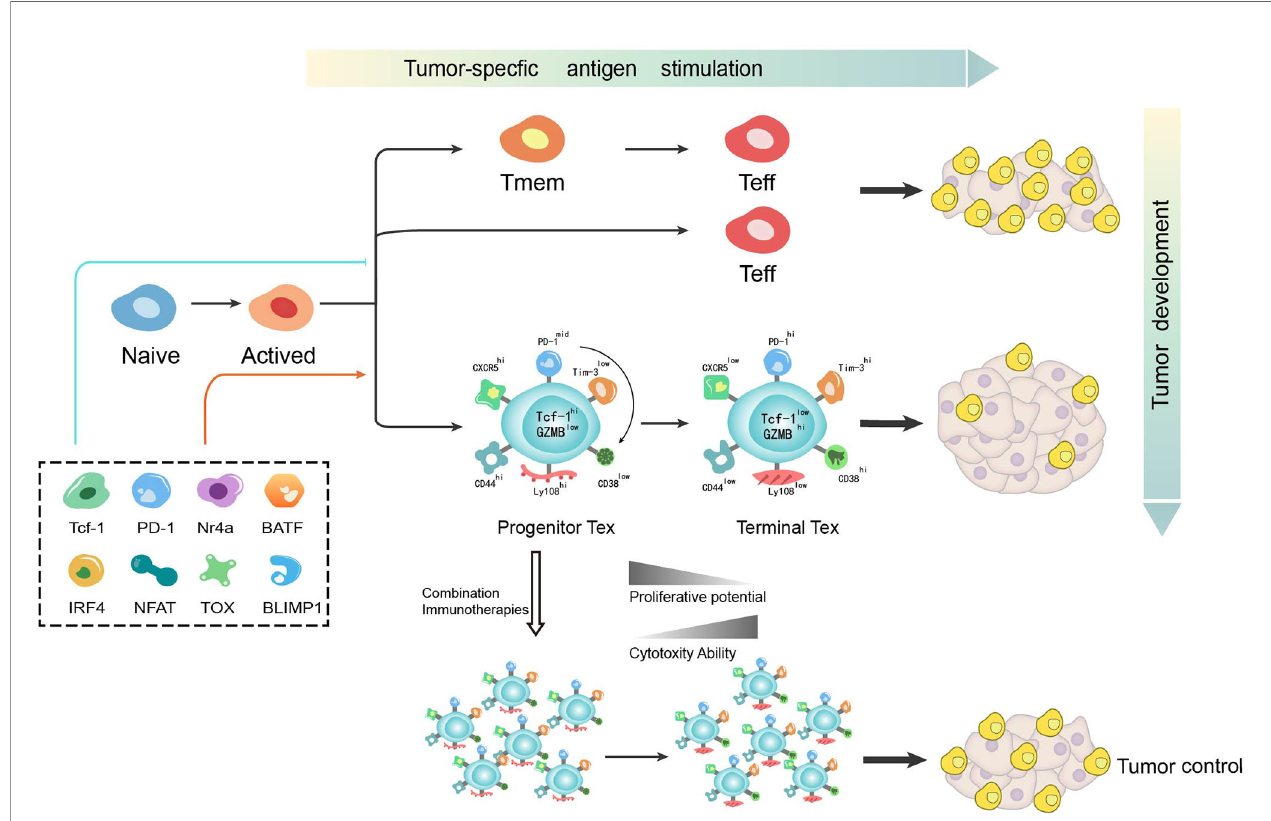
FIGURE 1 | T cell differentiation is a dynamic process during which various mechanisms function to determine the bifurcation from effector or memory toward exhaustion. T cell exhaustion has recently been identi fi ed as not a fi xed state whereby progenitor exhausted T cells give rise to terminally exhausted T cells. While progenitor exhausted T cells exhibit poor cytotoxicity but are long-lived with stem-like properties, terminally exhausted T cells have increased cytotoxicity but are short-lived. The distinct properties of exhausted T cells imply the potential of immunotherapy-based combination strategy in cancer treatment. Tmem, memory T cell; Teff, effector T cell; Tex, exhausted T